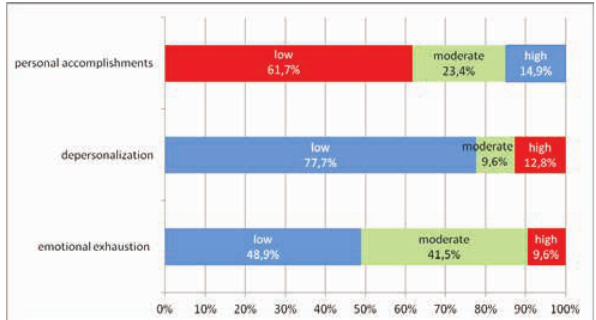
Figure 1: Risk of professional burnout as expressed in MBI-HSS